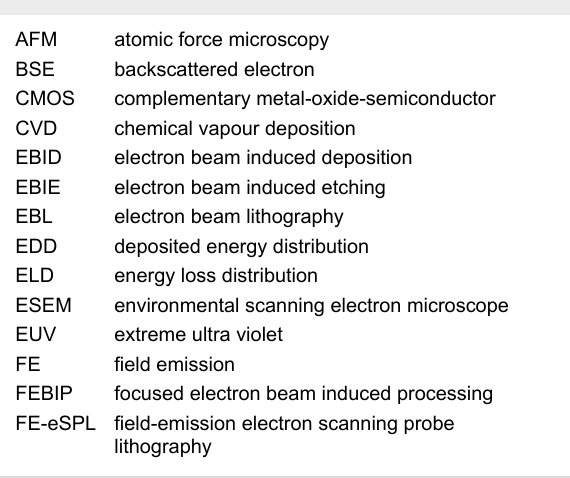
Table 3: List of